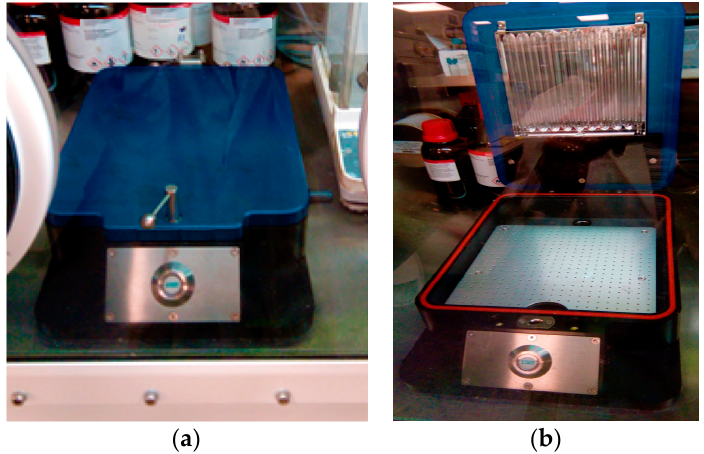
Figure 4. UV-O 3 cleaner used in the final step of the cleaning process of ITO-glass substrates shown both in the closed ( a ) and open position ( b ) and located inside the glove box.